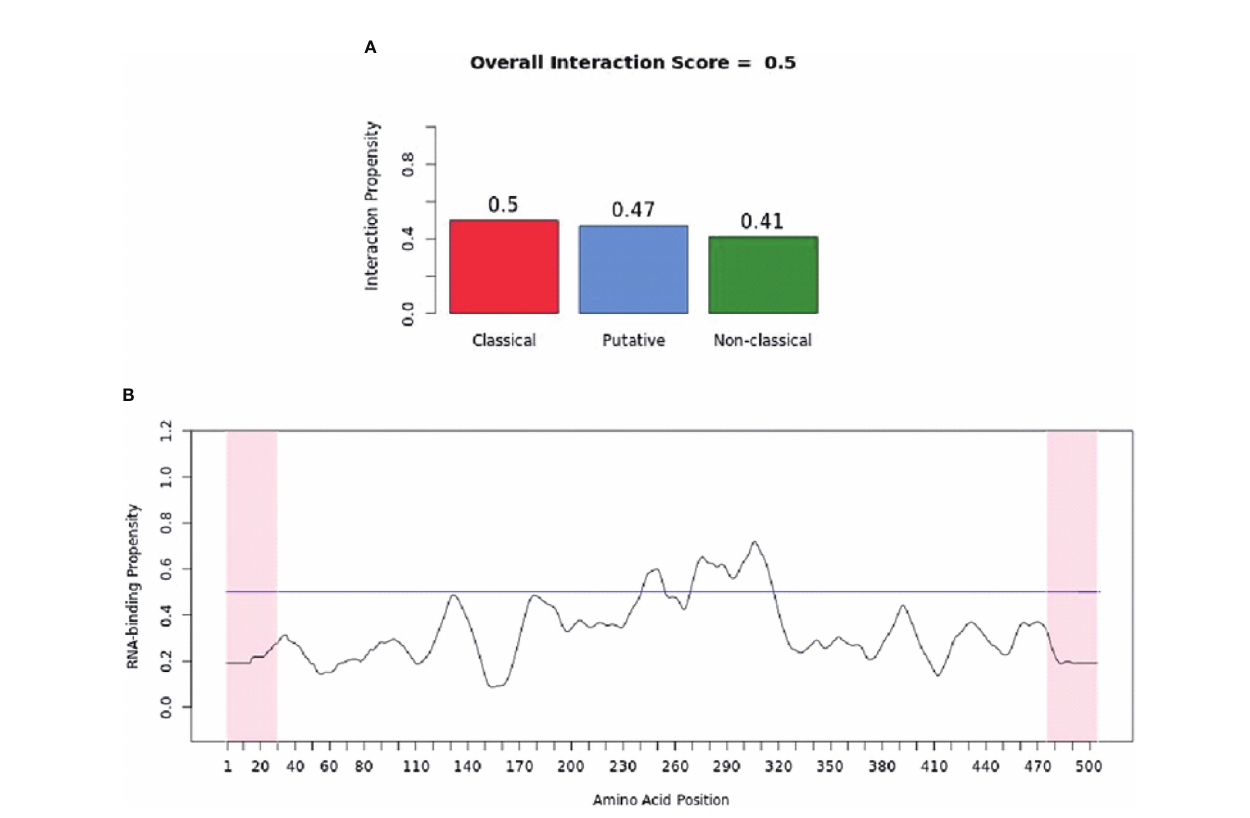
FIGURE 4 | RNA-binding ability of murine-cGAS determined by catRAPID signature. (A) The propensity of murine cGAS for classical (0.5), putative (0.47), and nonclassical (0.41) RBPs. The overall interaction score (0.5) for murine cGAS as an RBP was also present. (B) The pro fi le shows protein regions and their propensity to interact with RNA. All results were predicted by using